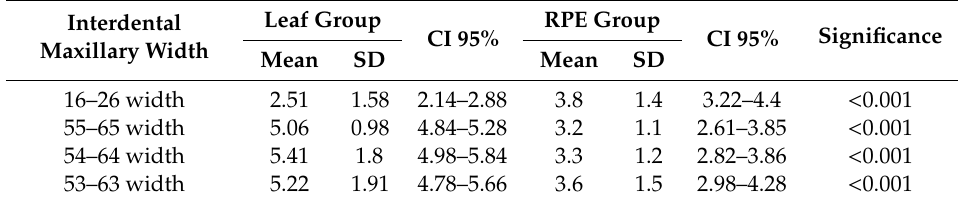
Table 6. T test for independent samples comparing the net ( ∆ T1 − T0) interdental width (mm) increase after Leaf (n ◦ 69) or RPE treatment (n ◦ 21)—maxillary arch.